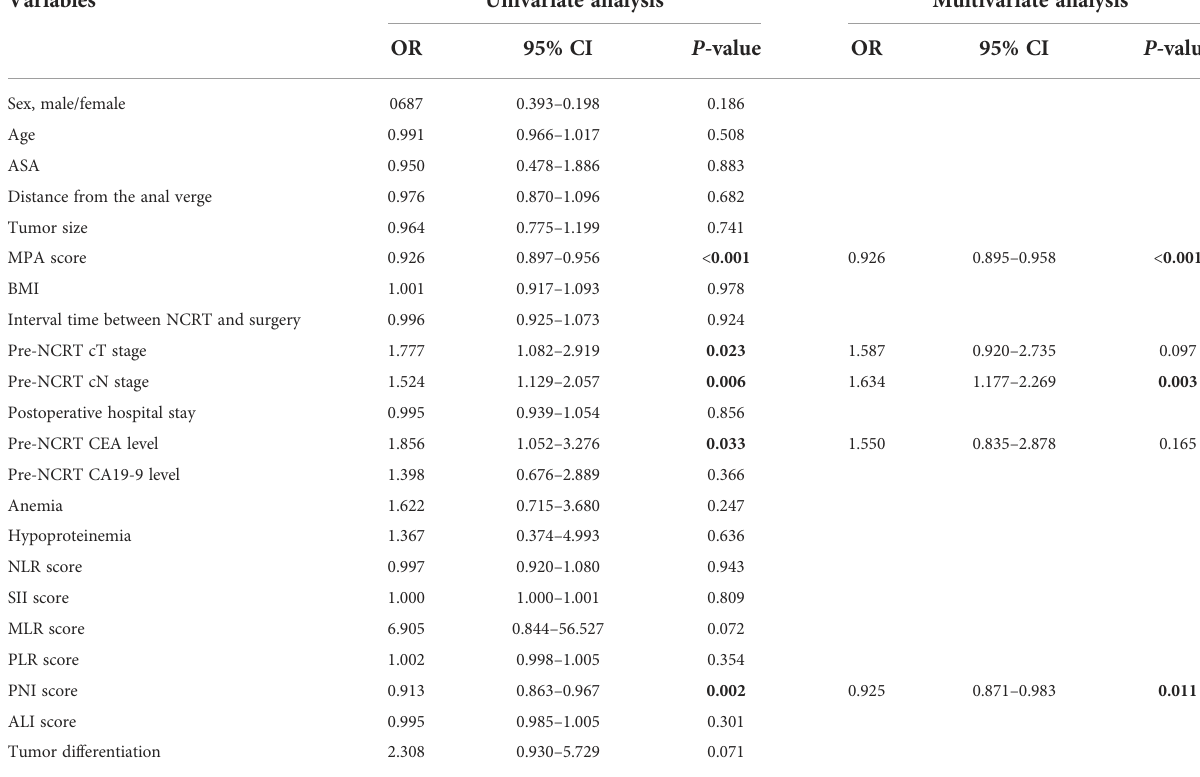
TABLE 4 Logistic regression analysis of predictive factors for pCR in patients with LARC after NCRT (n =